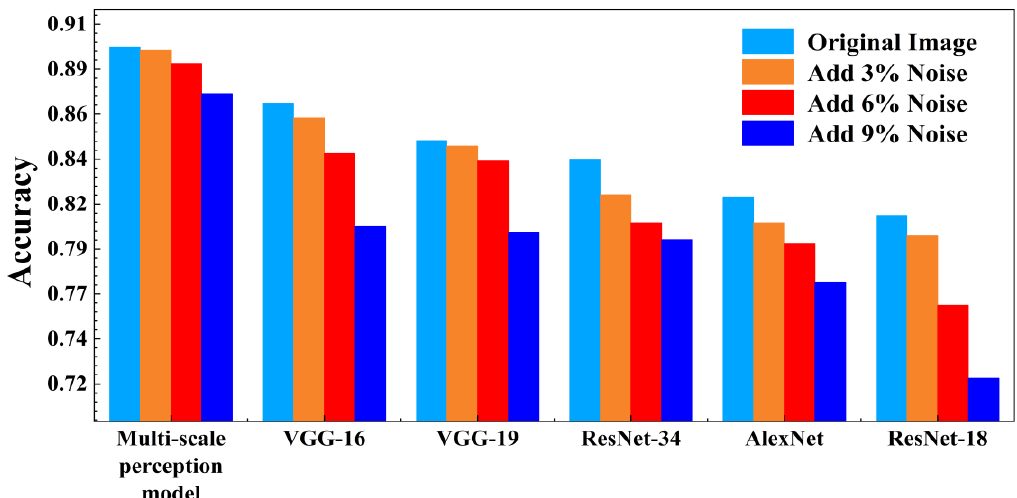
Figure 14. Comparison of different models after adding noise.